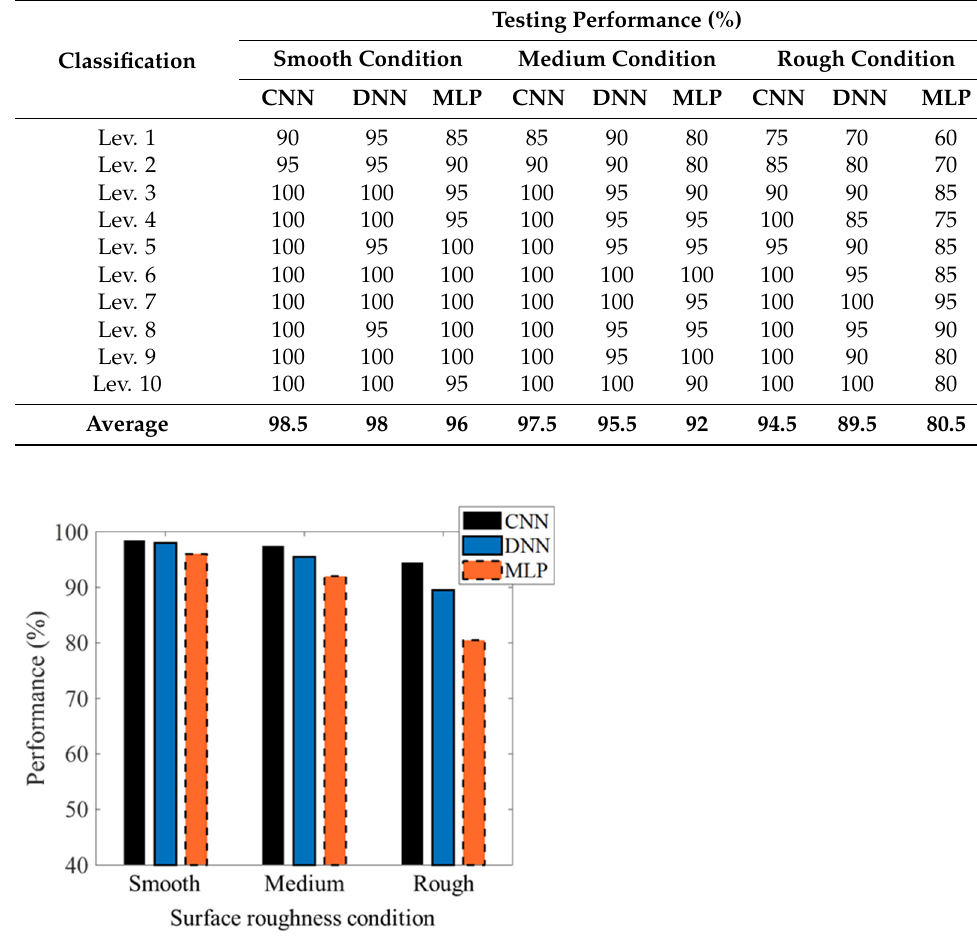
Figure 8. Performance of the CNN, DNN, and MLP models for the three different surface roughness conditions.